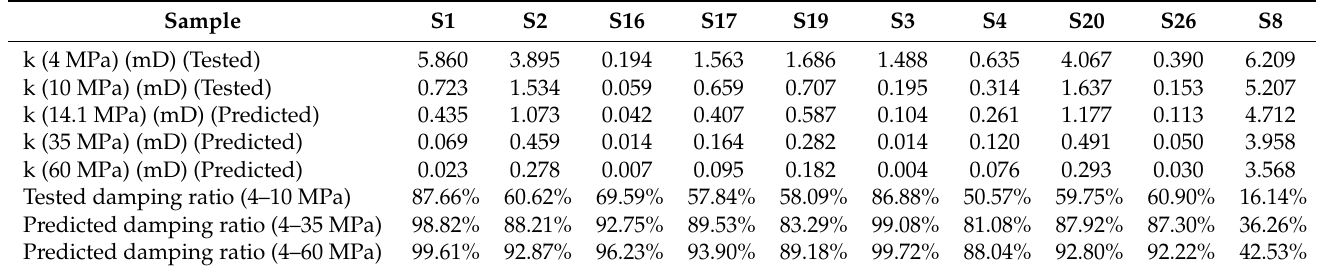
Table 2. Measured and predicted Klinkenberg sample permeabilities at various confining pressures.